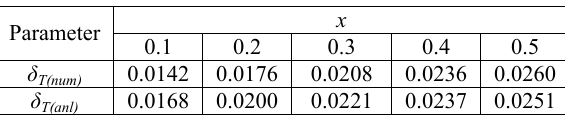
Table 2. Comparisons between numerical and analytical thermal boundary layer thickness ( δ T